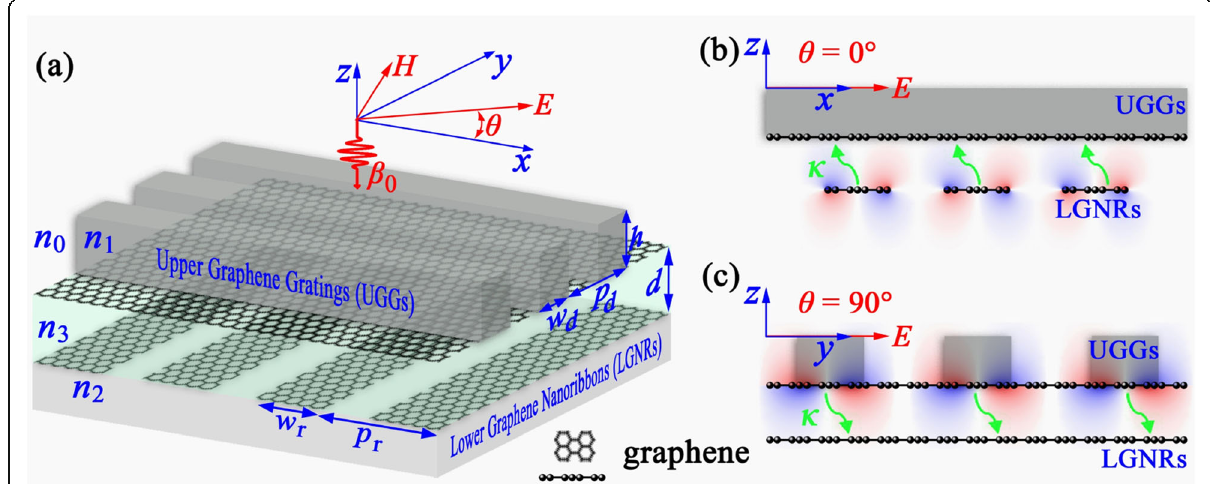
Fig. 1 3D ( a ) and 2D side views ( b , c ) of the proposed PIT system. One graphene layer loaded with periodic dielectric grating covers above one layer of periodic GNRs with crossed grating and ribbon directions. The upper graphene grating layer is designed with grating width W d , height h , and transverse period P d , while the lower graphene nanoribbons have ribbon width W r and period P r . The distance between the two graphene layers is d , which is assumed to be filled by a conductive Si or SiO 2 spacer with refractive index n 3 . The refractive indices of and over the dielectric gratings and bellow the GNRs are labeled as n 1 , n 0 , and n 2 , respectively. A linearly polarized plane wave with wave number β 0 and polarization angle θ with respect to the x -axis normally impinges the surface of the layered graphene